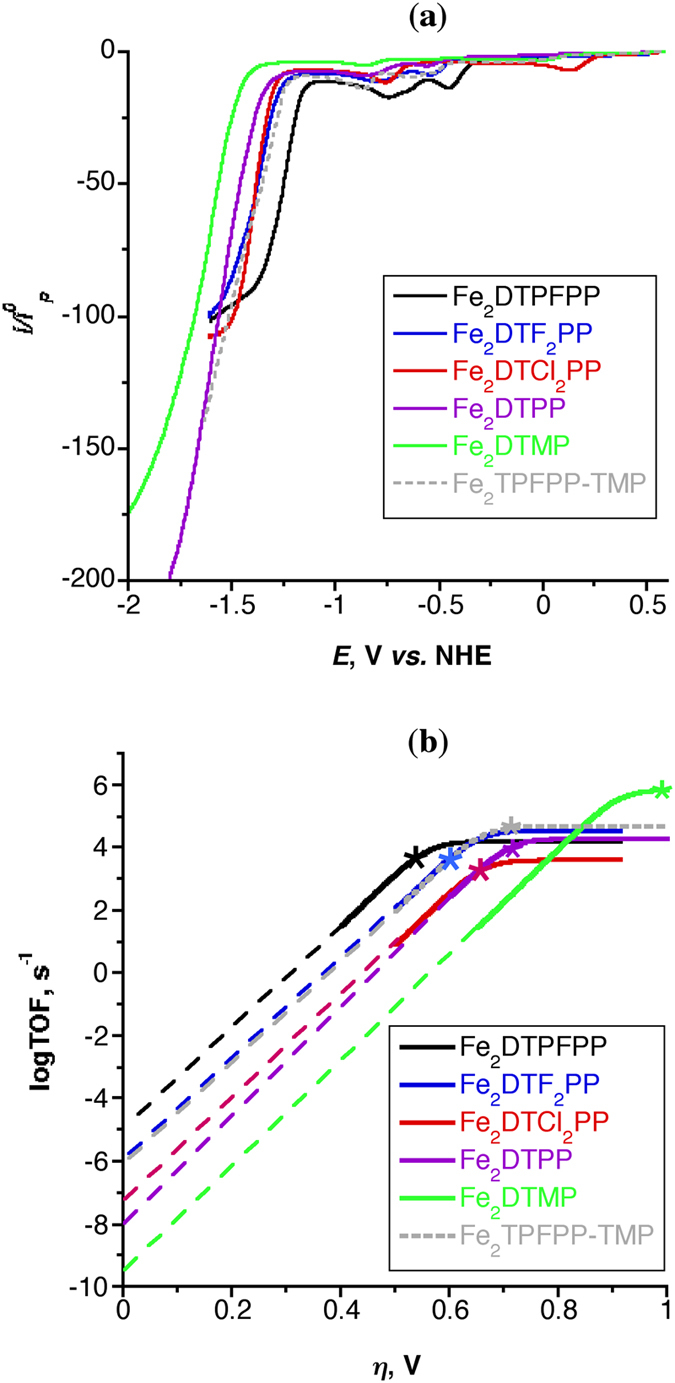
(a) Catalytic CVs responses (forward scan only shown for clarity) and (b) the Tafel plot [logTOF −η relationships] of the six Fe porphyrin dimers (0.5 mM) at 100 mV/s scan rate in DMF/10% H2O saturated with CO2. *logTOF resulted from bulk electrolysis experiments.